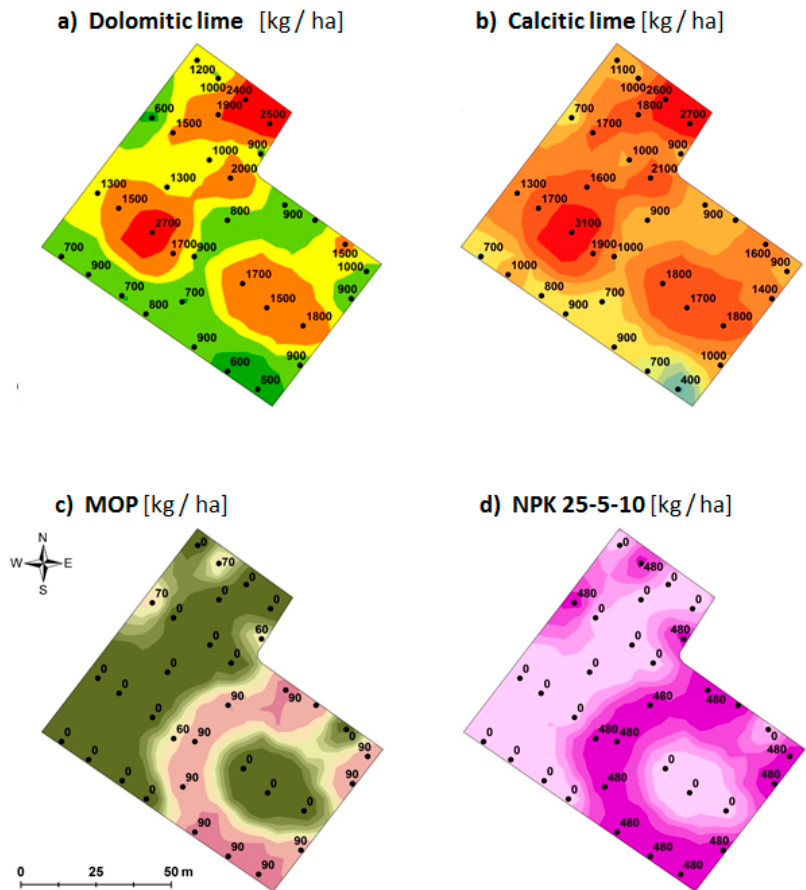
Figure 8. Spatial variation in input recommendations on the Kathande tea site. Because of the low pH (Table 1), pH correction by dolomitic and calcitic lime ( a , b ) was recommended. On this soil, there will be little response to inorganic fertilizer until lime is applied to correct pH and reduce aluminium levels. Recommended topdressing fertilizers are shown in ( c , d ). MOP (Muriate of Potash) = KCl. The recommendations are for a yield level of 7 tons tea per hectare. The calcitic lime should have a Ca content of 35%–40% and a Mg content <1%. The Dolomitic lime should have a Ca content of 20%–24% and a Mg content of 10%–14%. The recommended amount of lime is derived from target values for the Calcium percentage of base cations, which relates to pH—the rates are affected by cation exchange capacity, which is mainly determined by clay content in the soil. Recommended amounts are given as kg product per